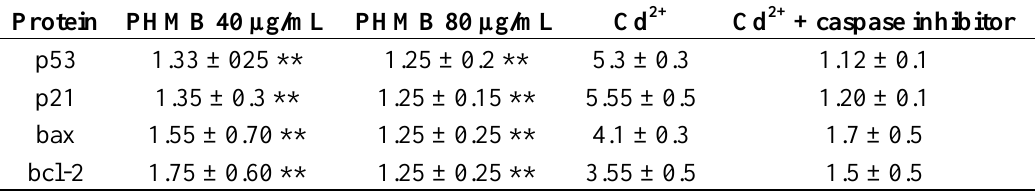
Table 11. Relative values of of p53 , p21 , bax , bcl-2 proteins in HepG2 incubated for 24 h. Measurements were made using the Koma-ELISA kit (Japan). Plates are pre treated by anti mouse antibodies that cross-react with the human antigen. Values are expressed as mean ± SEM without